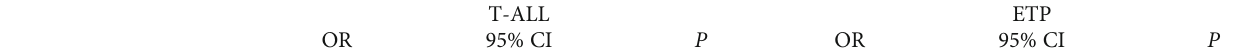
Table 4: T-ALL and ETP ALL regression analyses of induction